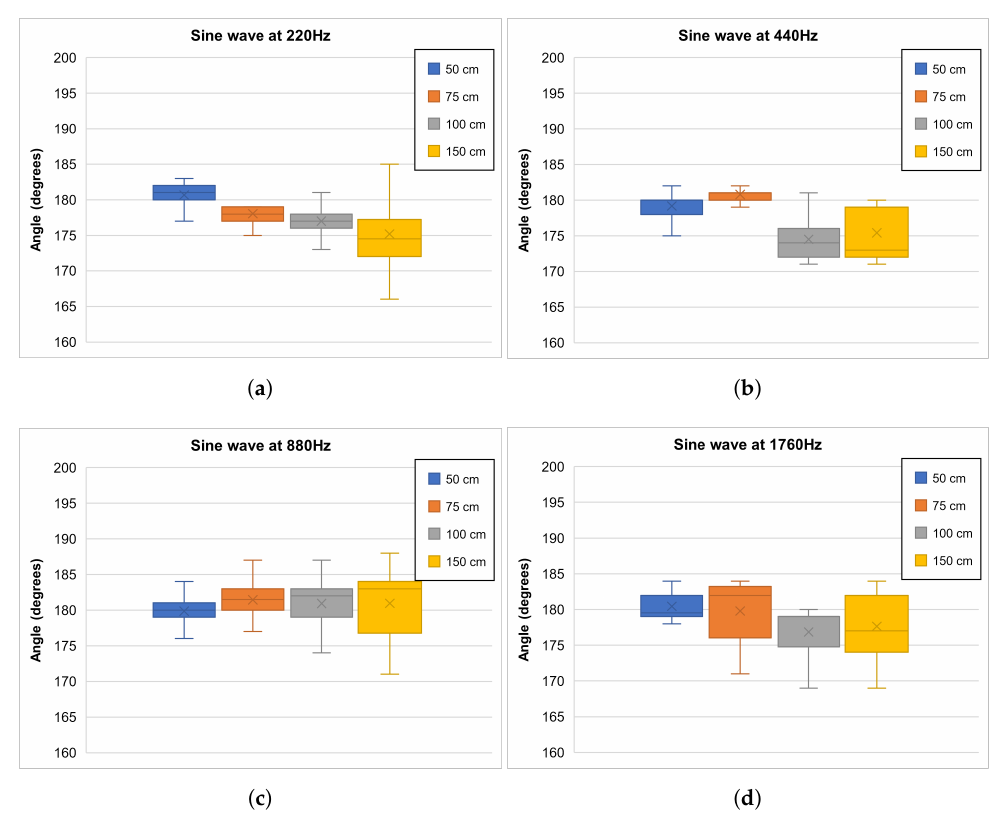
Figure 11. Box plot of the DoA measurements at different frequencies and distances. ( a ) Sine wave at 220 Hz. ( b ) Sine wave at 440 Hz. ( c ) Sine wave at 880 Hz. ( d ) Sine wave at 1760 Hz.